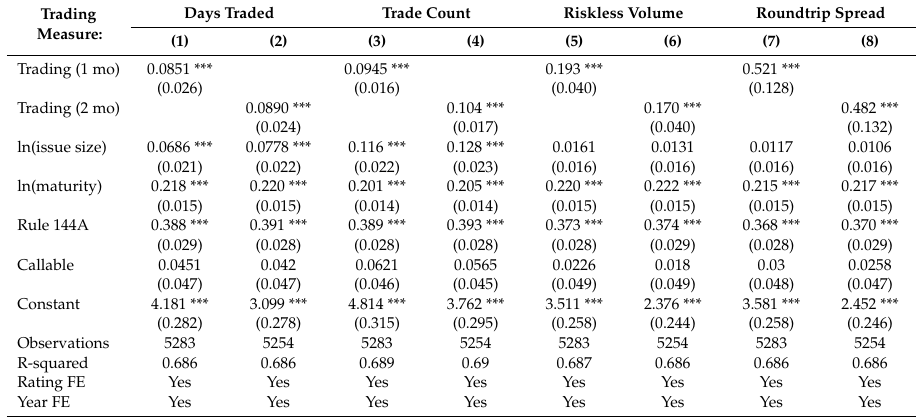
Table 3. O ff ering Yield Spread and Realized Secondary Market Trading